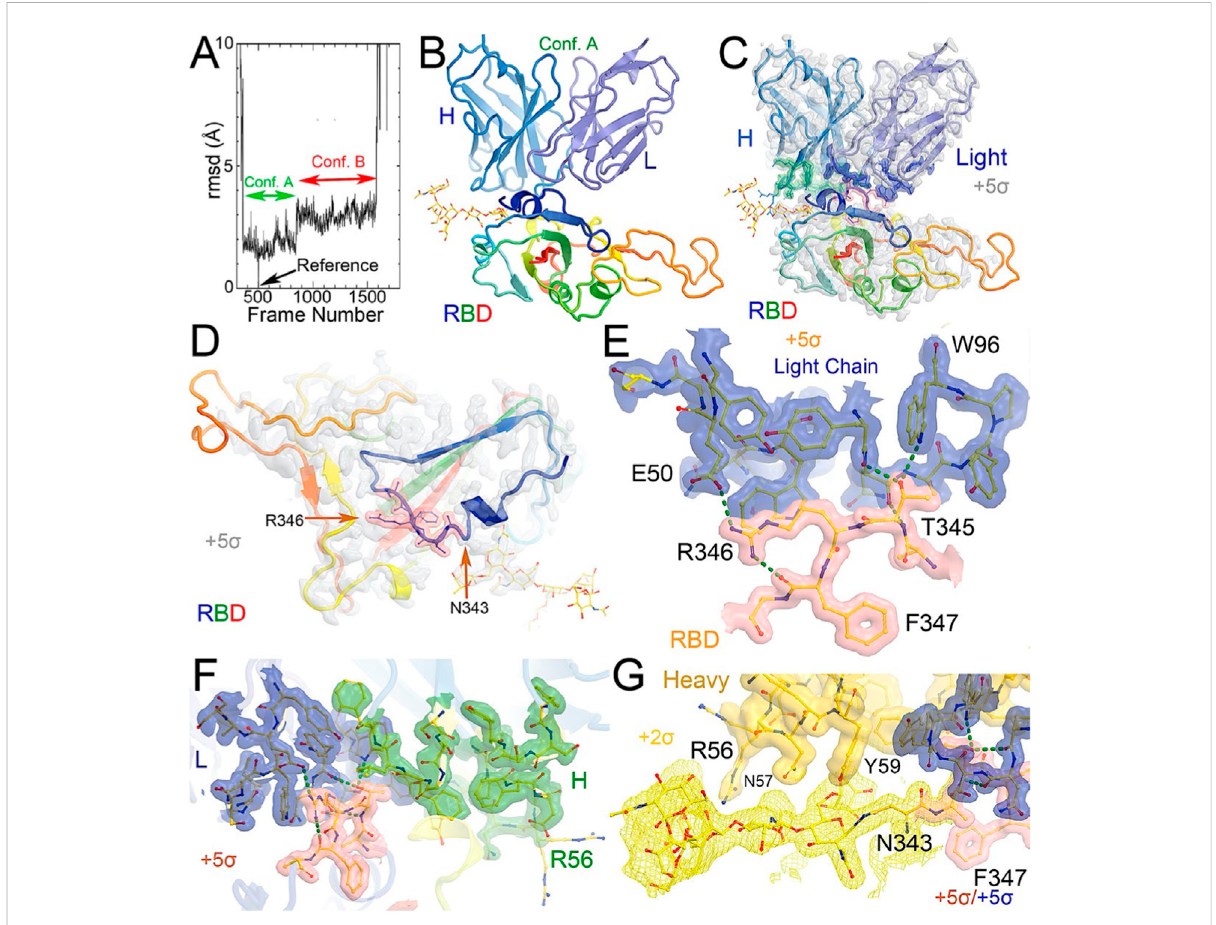
FIGURE 1 MD-derivedelectrostaticpotential(ESP)mapsandtheequilibratedstructureforNAbconformation. (A) Framescorrespondingtoconformation A (green arrow) and conformation B (red arrow). (B) Overall structure of conformation A between the spike RBD (rainbow colors with glycosylated N343inball-and-stick)andheavy(slate)/light(lightblue)chainsoftheC135Fab. (C) MD-derivedESPmapscontouredat+5 σ .Contactinterfacemaps are colored: light chain in blue, heavy chain in green, and RBD in pink. (D) Closeup view of the RBD with the map from (C) . (E) Interactions between the RBD and the NAb light chain. (F) Interactions among RBD, heavy/light chains with maps contoured +5 σ . (G) . Reduced contouring level to +2.5 σ for the heavy chain to show the features for N343